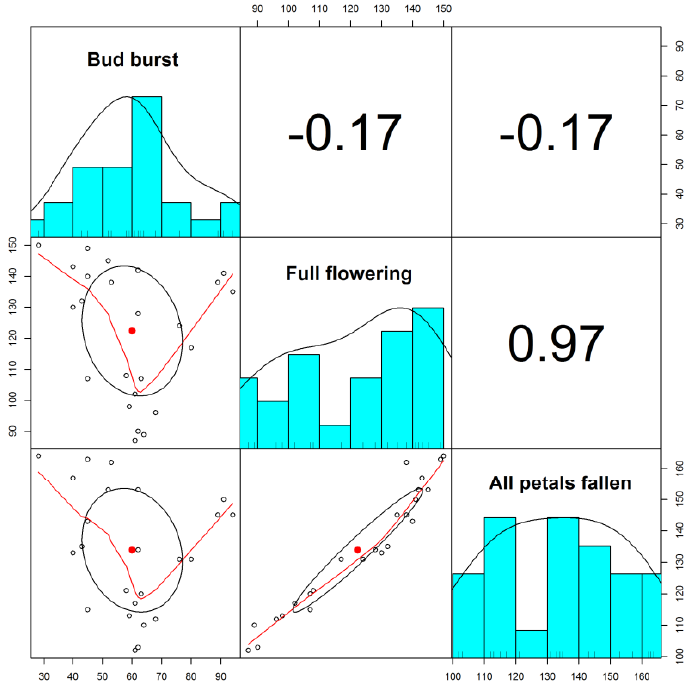
Figure 1. Correlation matrix for the 3 phenophases in the 8 species analysed.